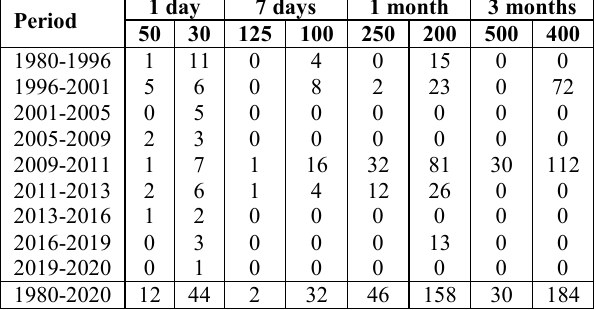
Table 8. Number of days in which a rainfall (mm) has been exceeded for the periods considered (photogrammetric surveys).